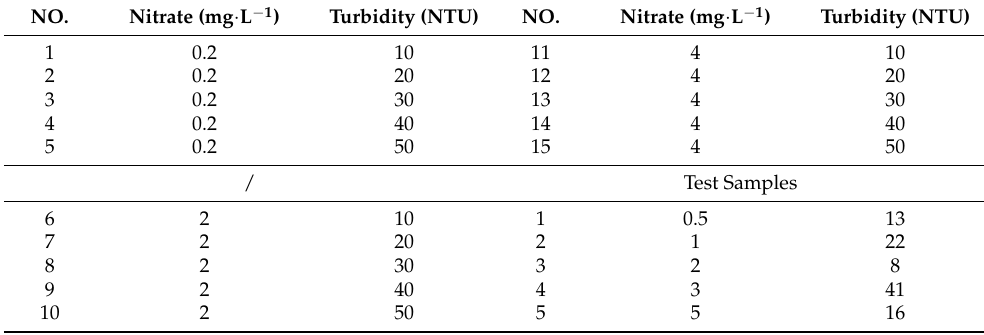
Table 3. Composition of the mixed-solution samples with varying levels of nitrate and